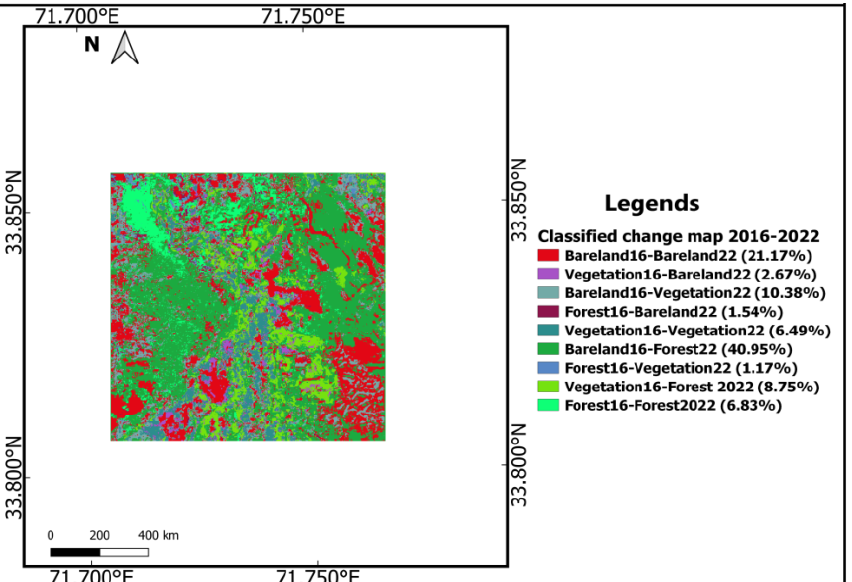
Figure 10. Change map for the years 2016–2022.